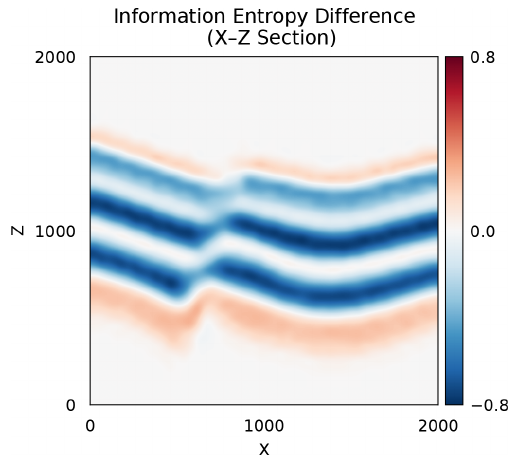
Figure 7. X–Y section of entropy difference between the forward simulated entropy and the approximate posterior entropy. The plot highlights areas where the entropy was reduced (blue), increased (red) and kept constant